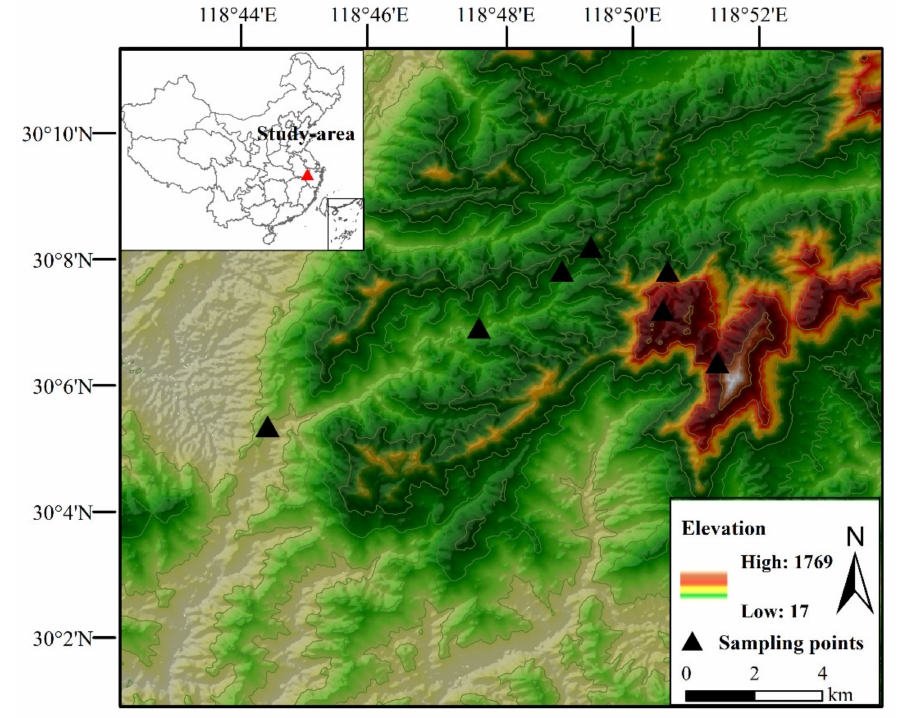
Figure 1. The map of the study area showing the extent of Qingliang Mountain, Anhui Province, China, and the sampling